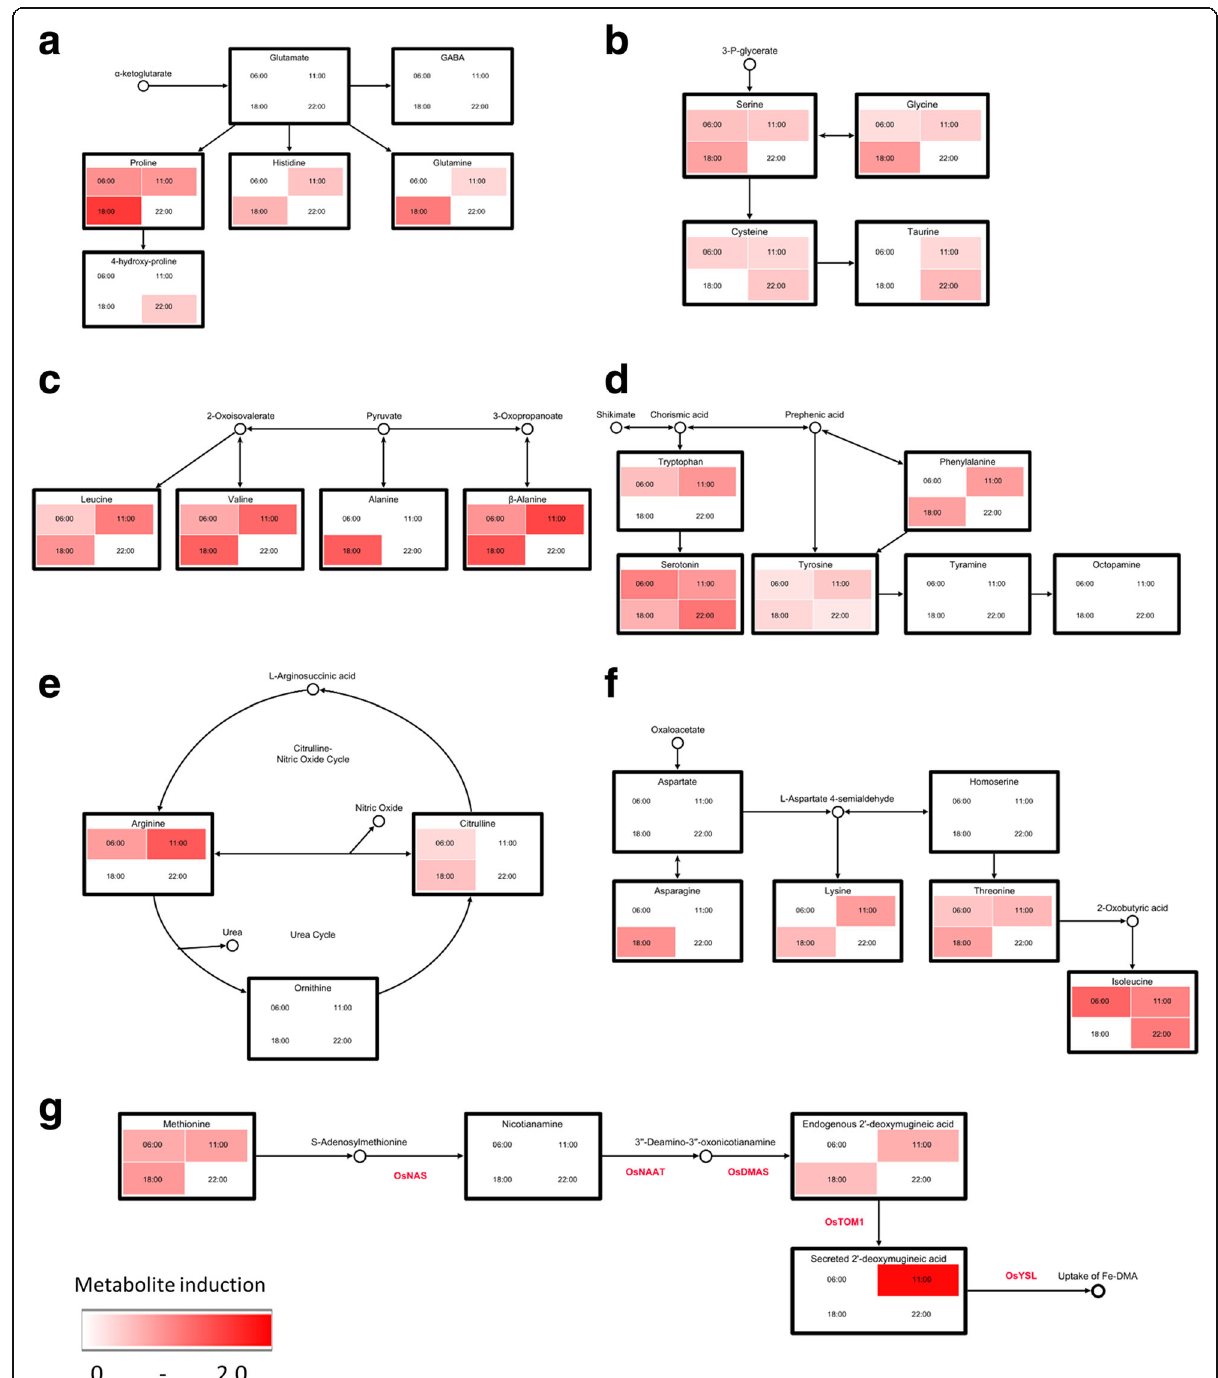
Fig. 5 Changes in metabolic pathways induced by Fe deficiency in rice roots. Heatmap (ranging from 0 – 2.0 as white – red ) of log 2 transformed Fe deficiency associated induction of metabolite concentrations in biochemical pathways of a α -ketoglutarates, b 3-P-glycerates, c pyruvates, d aromatic amines, e Cit-NO/urea cycle, f aspartate family amino acids and g DMA biosynthesis and